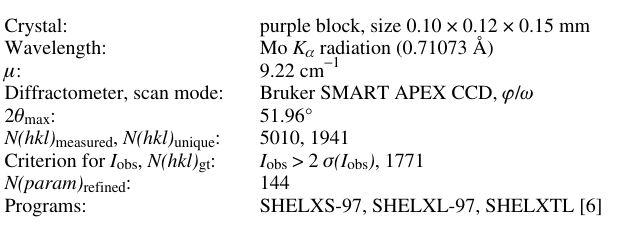
Table 1. Data collection and handling.